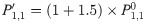
Detection rates against shift time within the aggregation period for communication count data from |V| = 20 networks with 2 communities.P1,1′=(1+1.5)×P1,10.